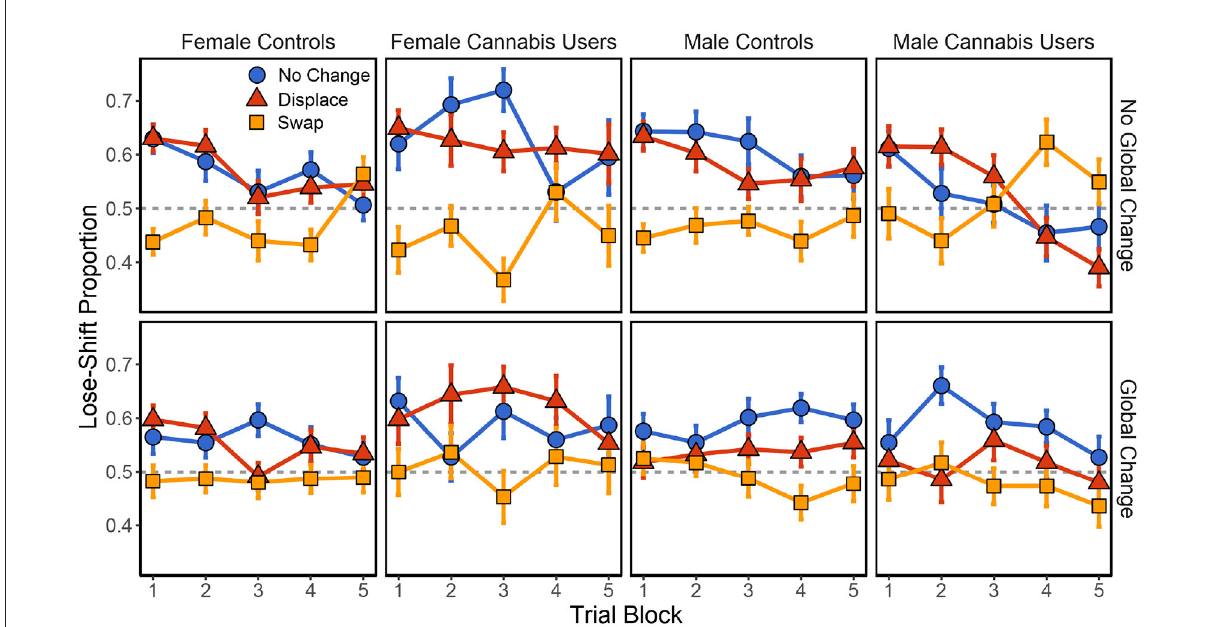
FIGURE4 Effect of local and global changes in choice position on lose-shift tendencies in male and female cannabis users, relative to controls. SEM in error